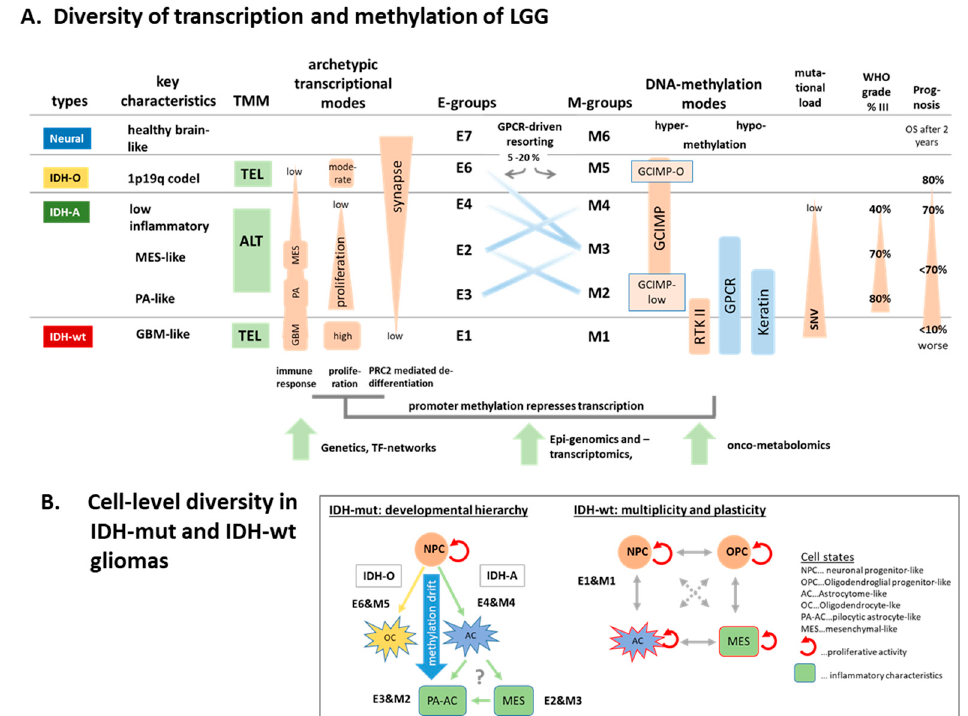
Figure 9. Schematic overview: ( A ) Major characteristics, cell functions, and methylation modes of the LGG types. ( B ) Cell-level view suggesting that aberrant DNA methylation shapes IDH mut gliomas into a developmental hierarchy while IDH-wt gliomas consist of multiple cellular states. The scheme was partly adapted from [98] on the basis of recent single-cell transcriptomic studies [66,67,99,100] and our mapping of single cell glioma signatures (Figure S11). See text.